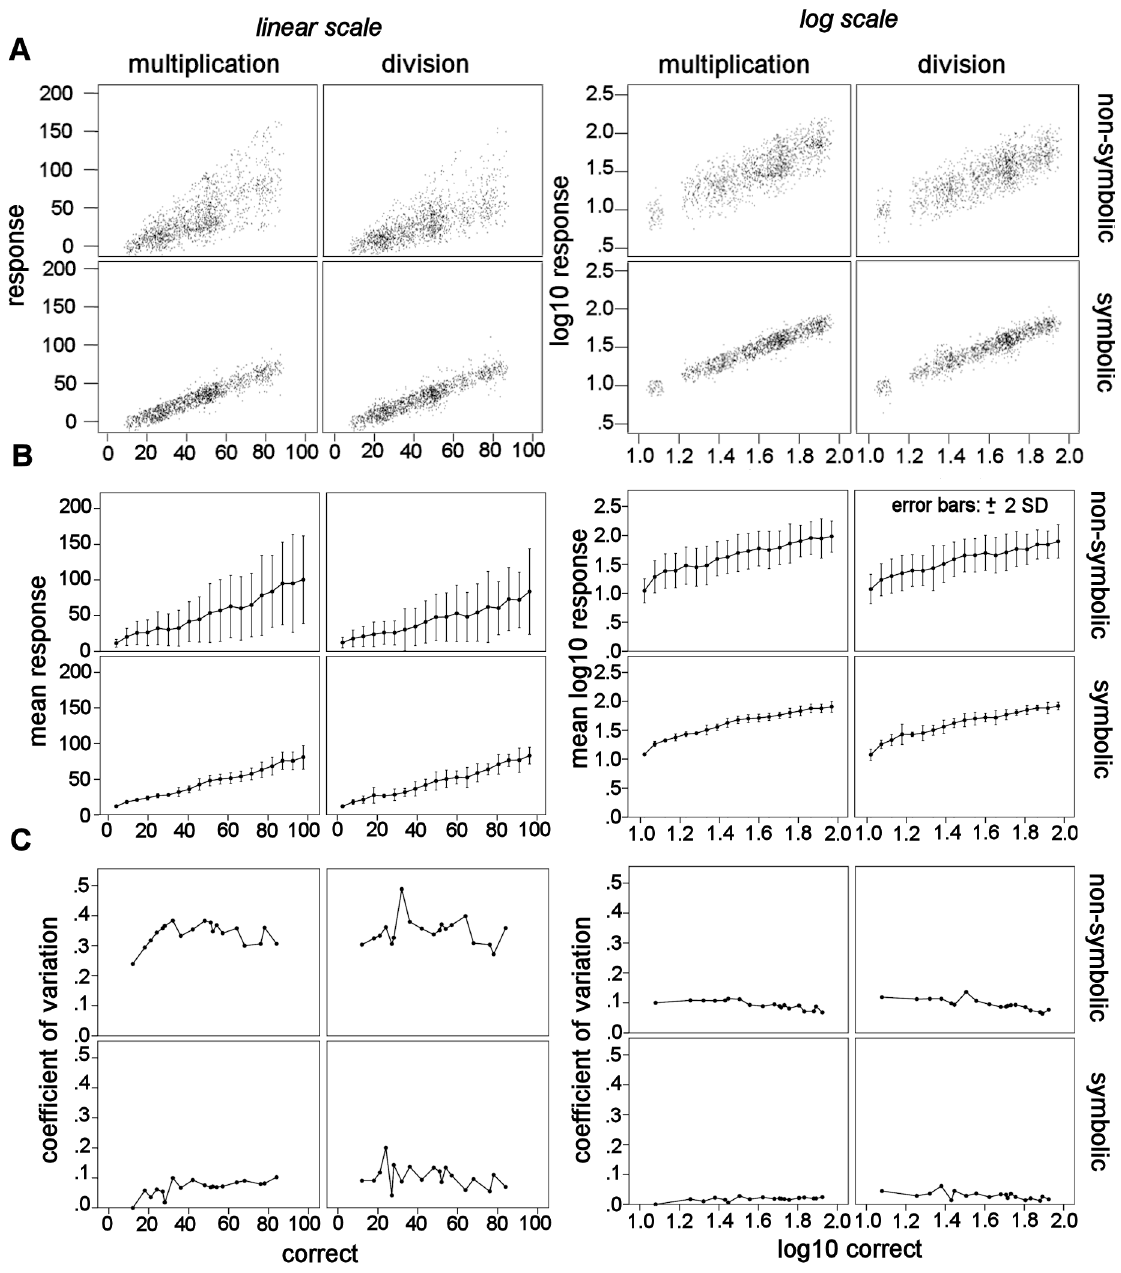
Figure 3. Response value as a function of correct value on linear and log-scale data. (A) Non-aggregated response value as a function of correct value, on the linear (left) and log (right) scale. Number of cases is shown by increased density ( i.e. darker color). (B) Linear response value and SD increased as a function of correct value, consistent with Weber’s law. Log-transformed response value, but not SD, increased as a function of log- transformed correct value ( i.e. linear on the log scale). (C) Dispersion of response choices, measured by the coefficient of variation, was constant across correct values on the log scale, but not on the linear scale. Dispersion was constant when log-transformed values were used.